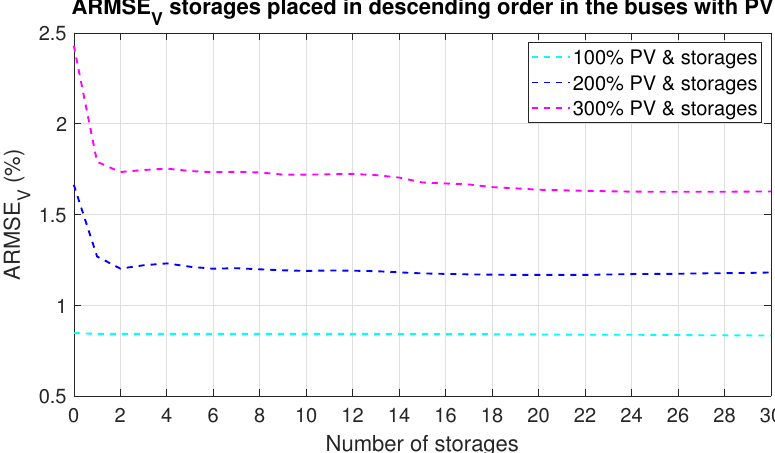
Figure 10. ARMSE of voltage across all buses and over a week for storages deployed in descending